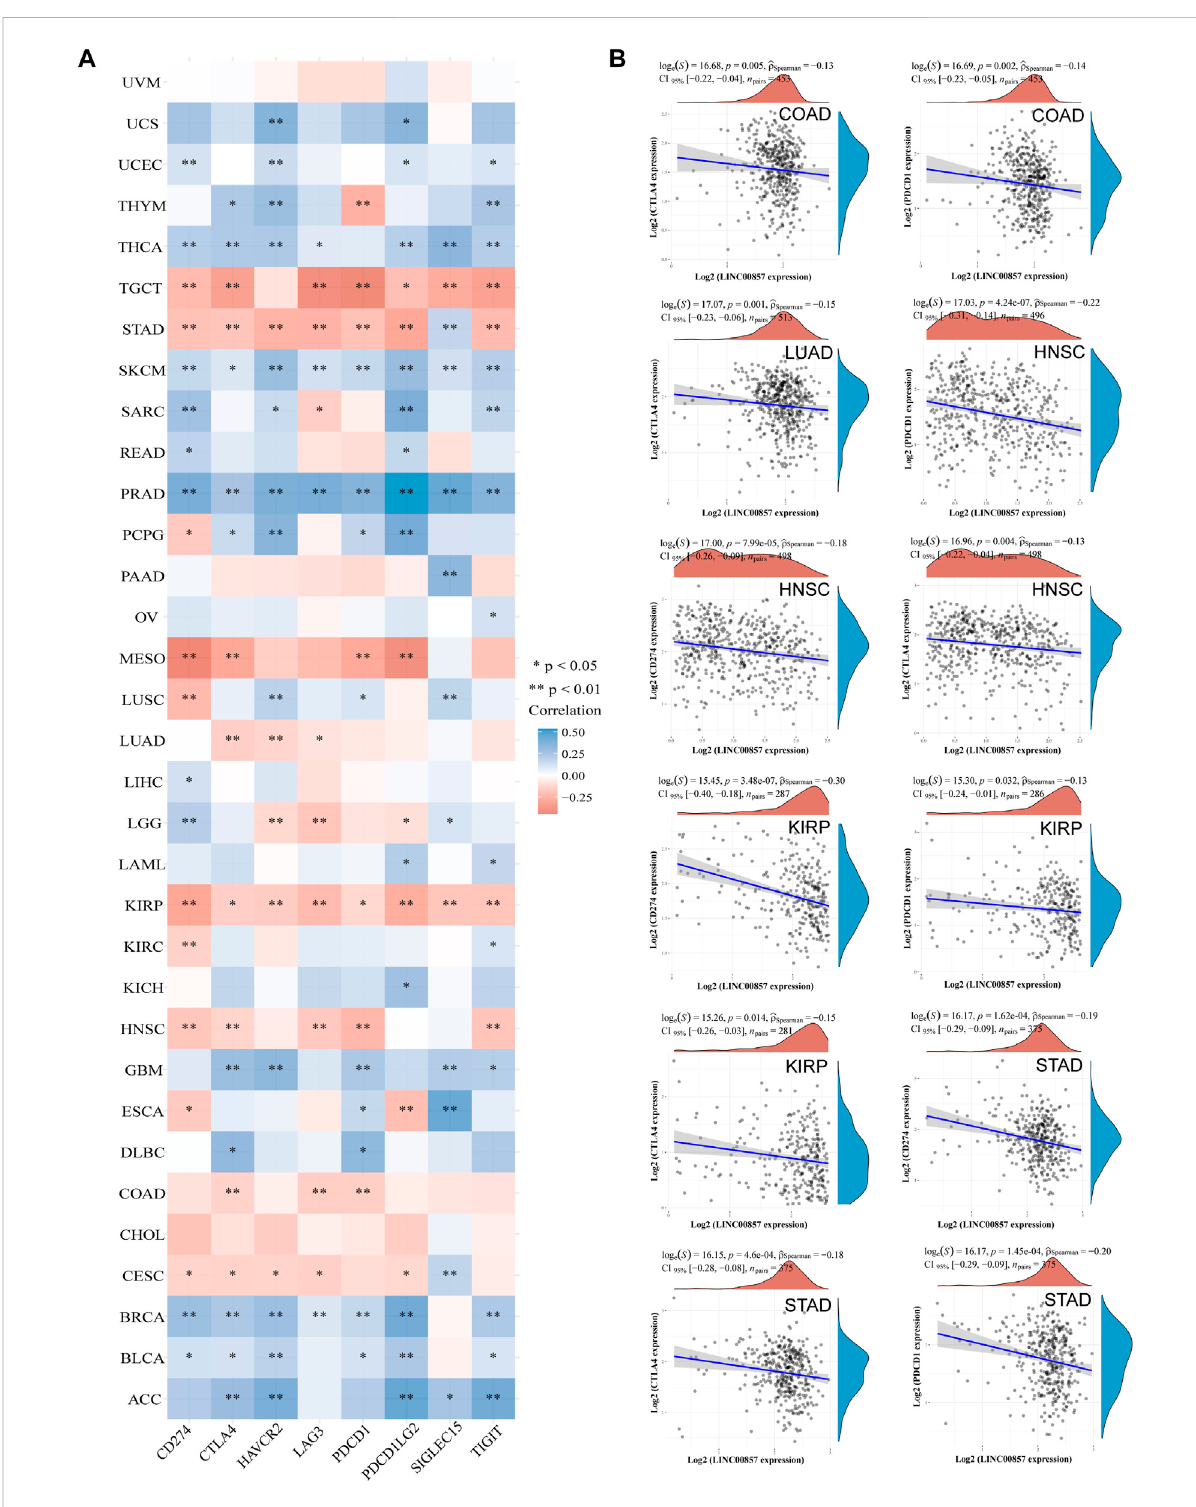
The correlation between LINC00857 and immune checkpoint genes expression. (A) Correlation mapping of LINC00857 expression with immune checkpoint genes in pan-cancer by the ACLBI database. (B) The correlation between LINC00857 and PD-L1(CD274), PD1 (PDCD1) or CTLA4 expression was shown via the scatter plot (* p < 0.05, ** p < 0.01, *** p < 0.001, Spearman